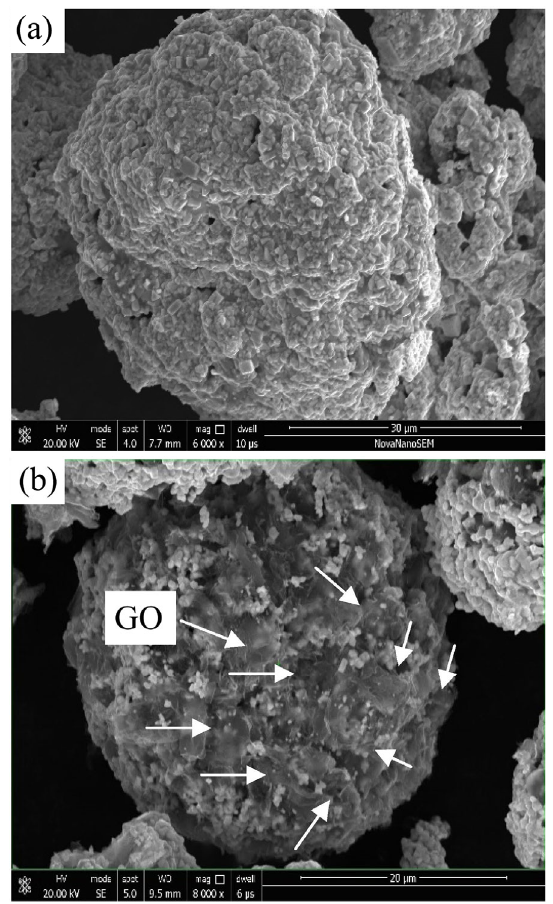
Fig. 2 SEM morphologies of the spray powders: (a) WC–12Co and (b)